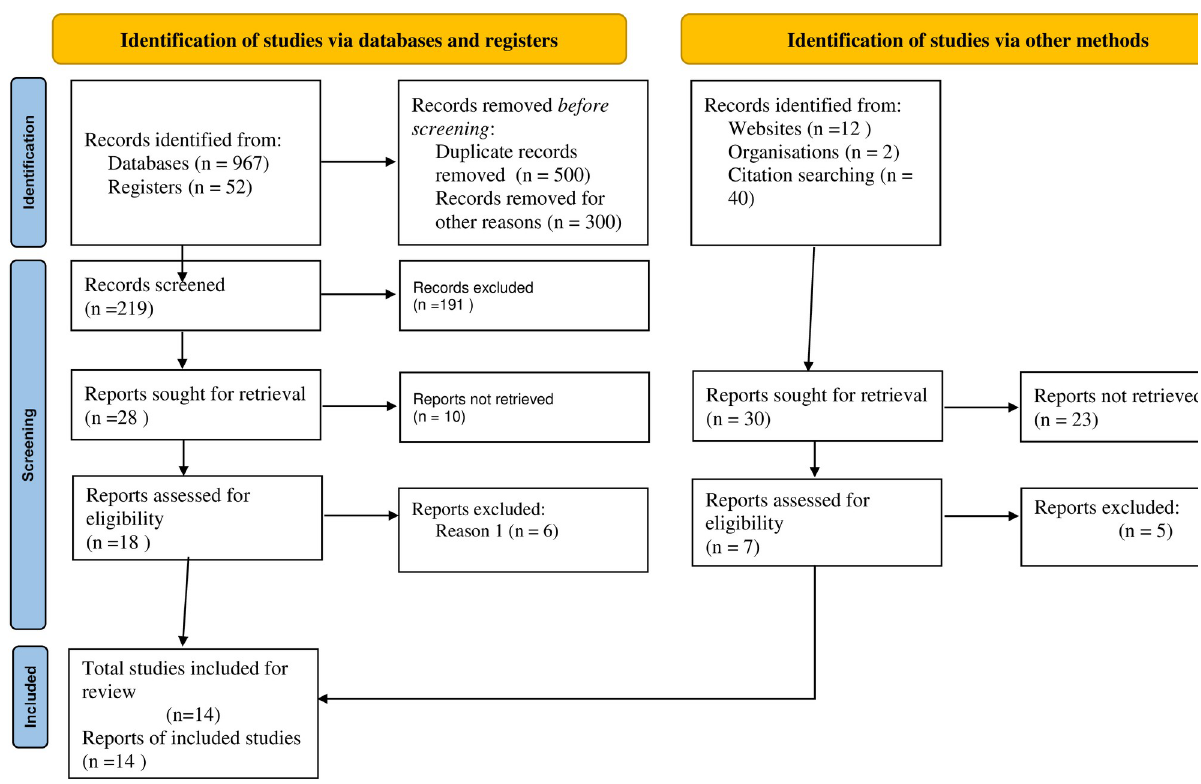
Fig 2. The subgroup analysis of tinea ccapitis over region in